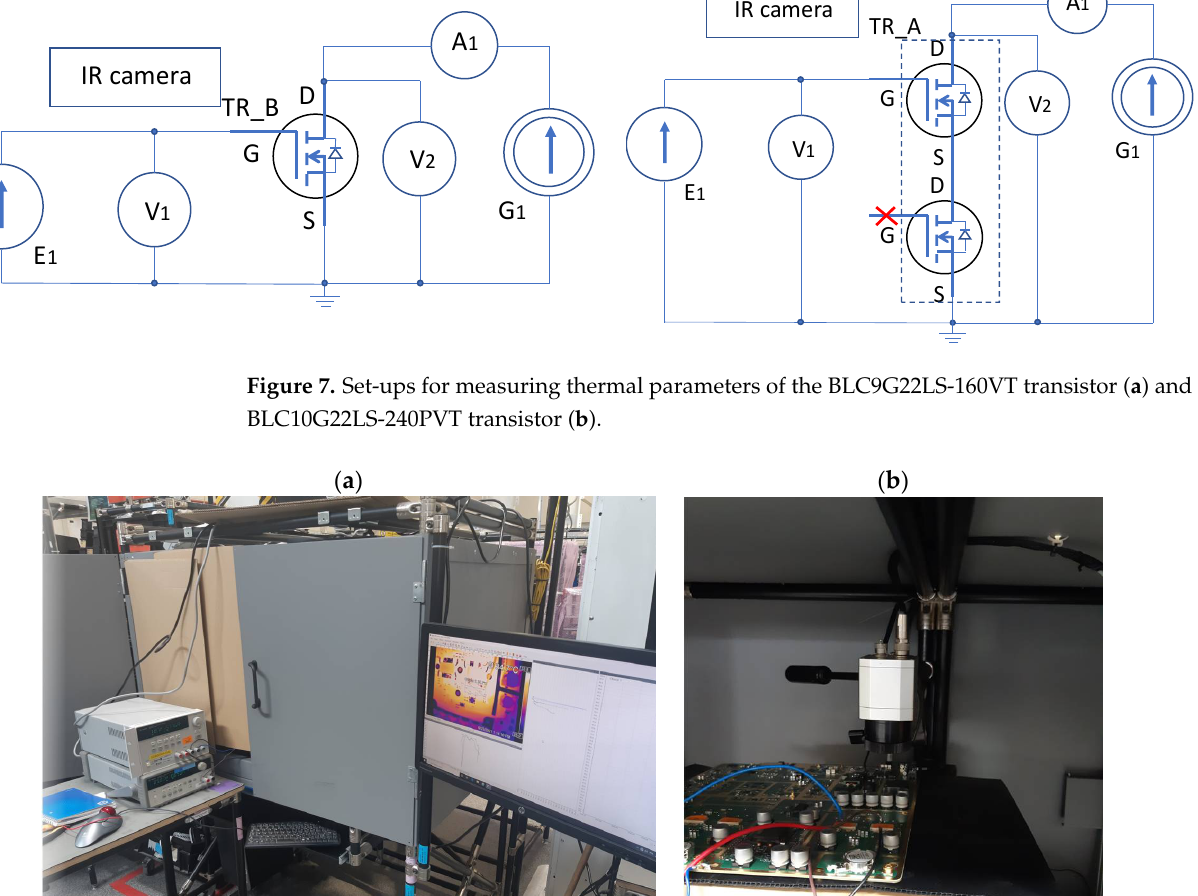
Figure 8. View of the measuring stand ( a ) and the inside of the measuring chamber ( b